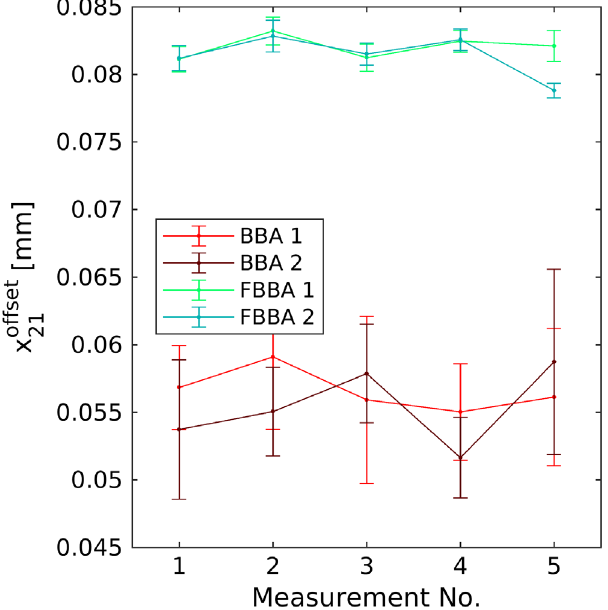
FIG. 14. Reproducibility of both BBA and FBBA for the BPM no. 21 in the horizontal plane over 5 consecutive measurements with (curves 1) and without (curves 2) magnetic cycles.